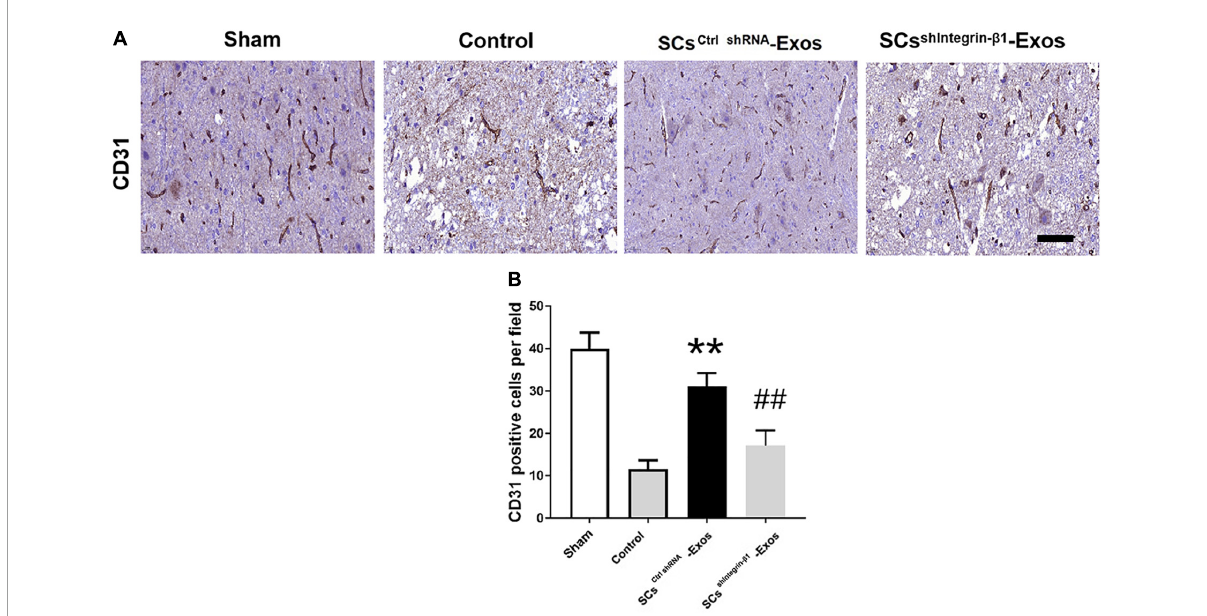
FIGURE5 Exosomal Integrin- β 1 of SCs-Exos promotes angiogenesis after SCI. (A) The presence of blood vessels in the spinal cord at day seven after SCI indifferent treated groups were analyzed by CD31. (B) Quantification of the number of CD31-positive cells in each group. The data are